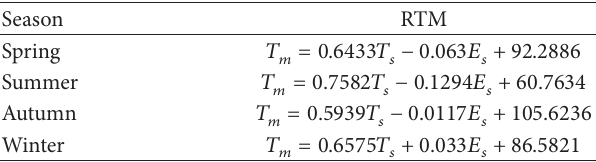
Table 4: Four seasonal two-factor RTMs during the period of 2012-